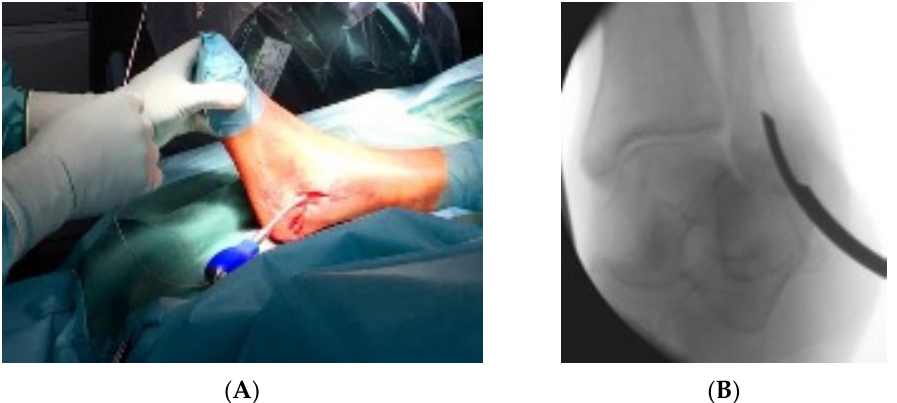
Figure 2. ( A ) demonstrates the insertion of the 4 mm cannulated awl with the corresponding intraoperative fluoroscopic control ( B ).